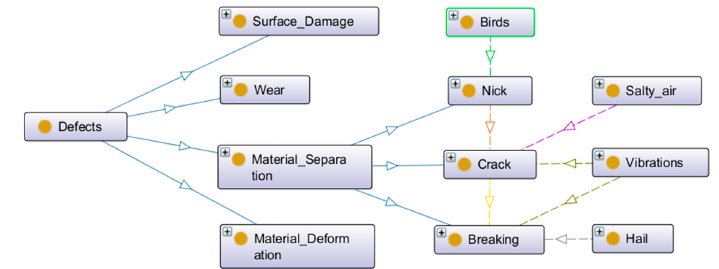
Figure 2. Extract from the ontology.